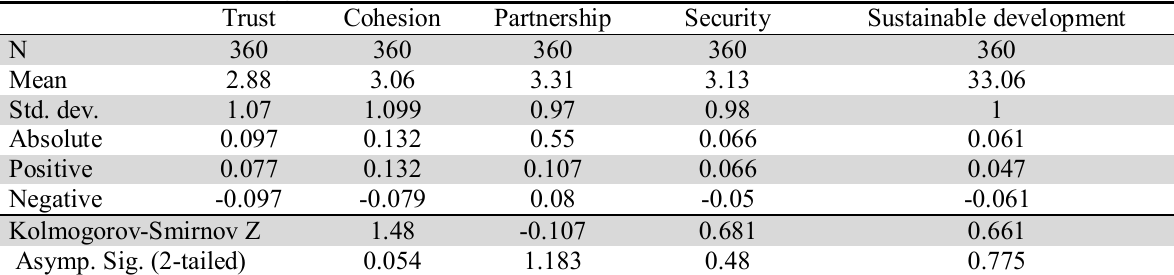
The summary of Kolmogorov-Smirnov test Trust Cohesion Partnership Security Sustainable